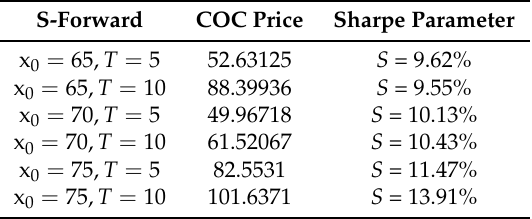
Table 8. Equivalent Sharpe parameters, HW model.